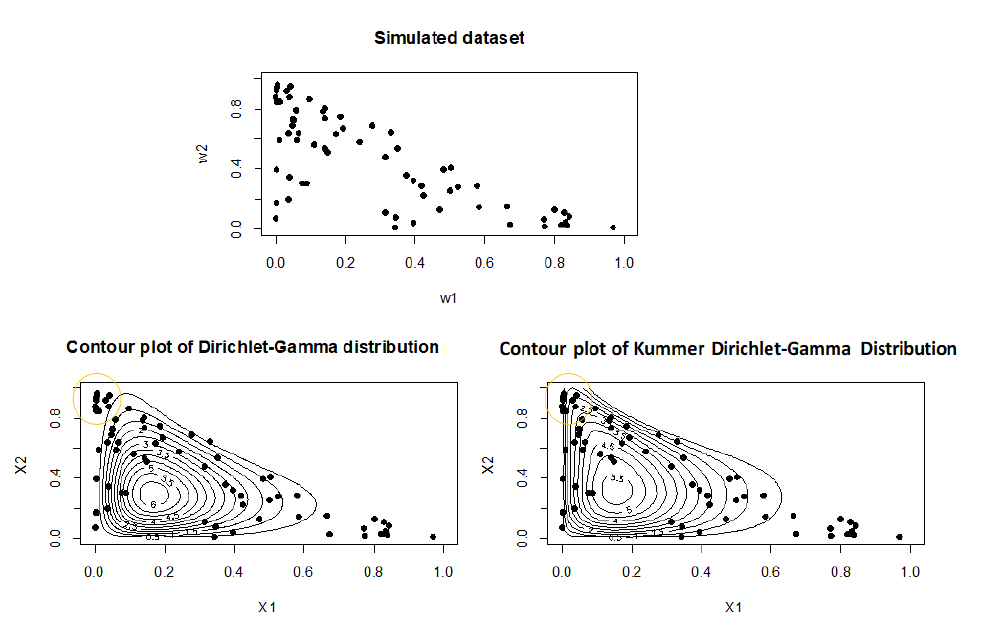
Figure 5. Performance of the Kummer–Dirichlet gamma and Dirichlet-gamma distributions on the synthetic compositional data set generated using Algorithm 3.